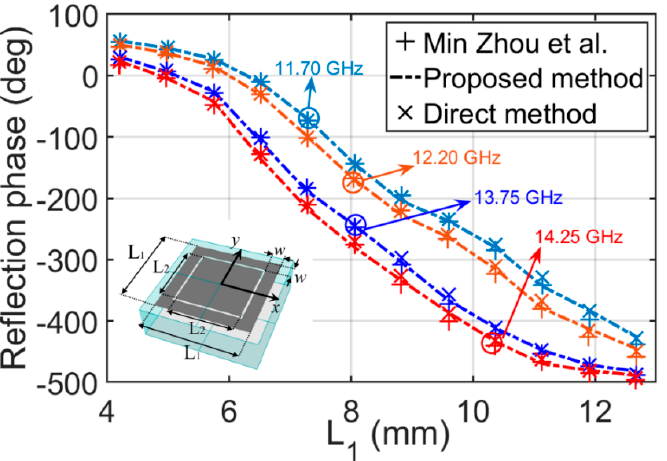
Figure 9. The phase curves shown in Figure 3 of [34] and the reproduced results by the proposed and direct methods.